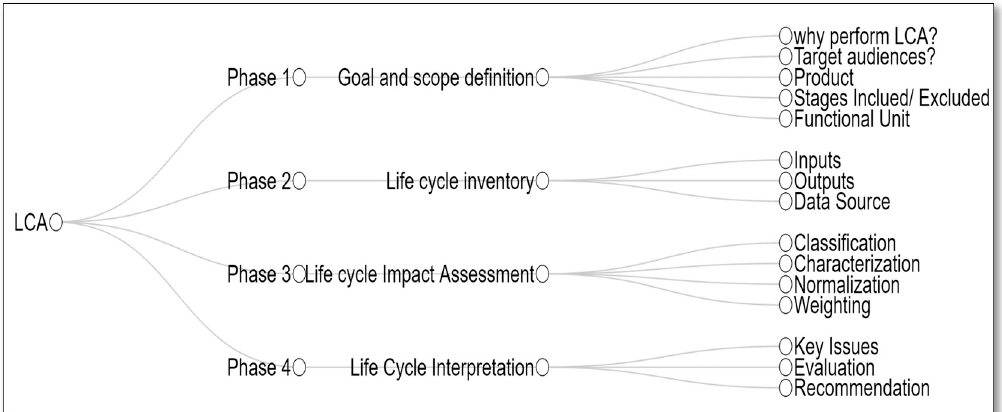
Figure 3. Overview of life cycle assessment (LCA) phases.